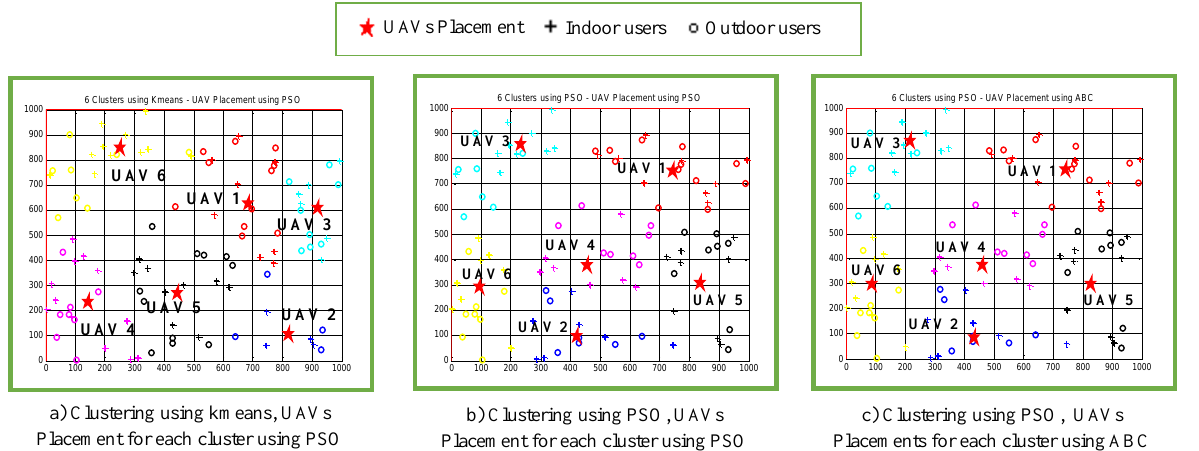
Figure 7. Placement of UAV1 to UAV6 when users were uniformly distributed. ( a ) Clustering using K -means, UAV placement using PSO. ( b ) Clustering using PSO, UAV placement using PSO. ( c ) Clustering using PSO, UAV placement using ABC. Meanwhile, the convergence speed of the proposed algorithm that iteratively invoked PSO-based clustering algorithm and PSO-based efficient UAV 3D placement for the six UAVs is shown in Figure 8. It can be observed from this figure that the proposed algorithms converge to the total UAV transmit power smaller than the threshold value of 1 watt within a few iterations.